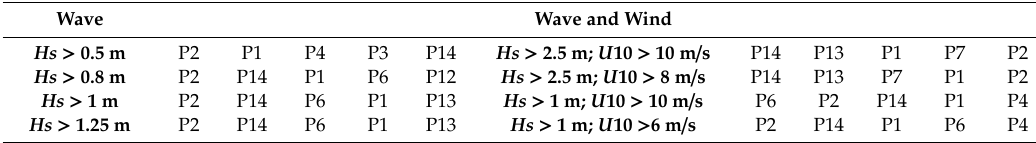
Table 4. Top five sites reporting the longest sequences of adverse weather conditions.